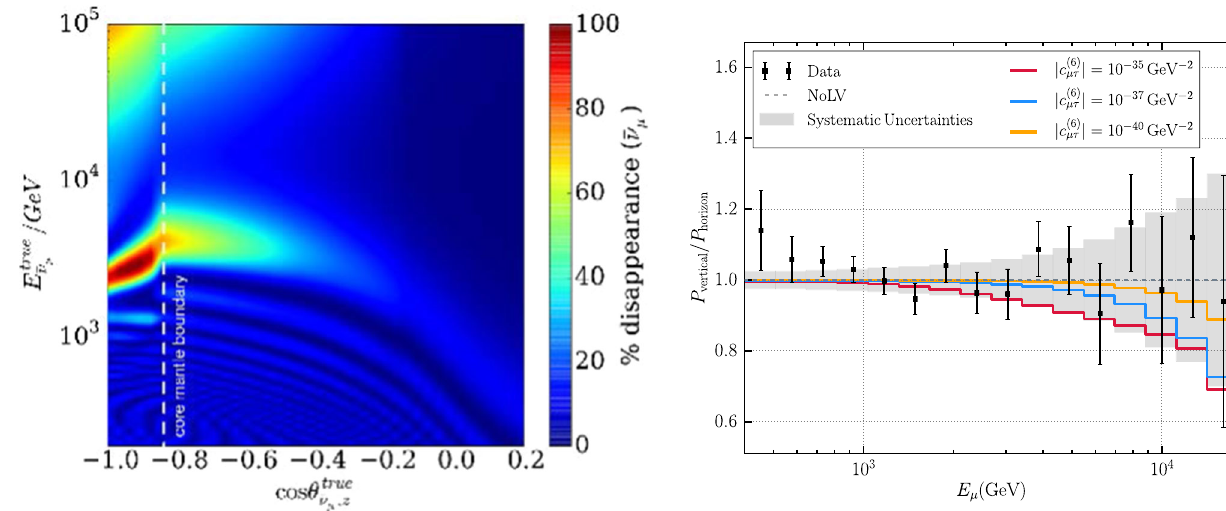
Fig. 16 SignaturesofflavorchangeinTeVneutrinos.Leftpanelshows the antineutrino survival probability as a function of the neutrino energy and the cosine of the zenith angle. Earth-core-through going muon- antineutrinos (cos θ = − 1) experience a significant matter-resonant- enhanced depletion at TeV energies for an eV sterile neutrino with non-zero muon-neutrino mixing. Figure is taken from Ref. [779]. Right